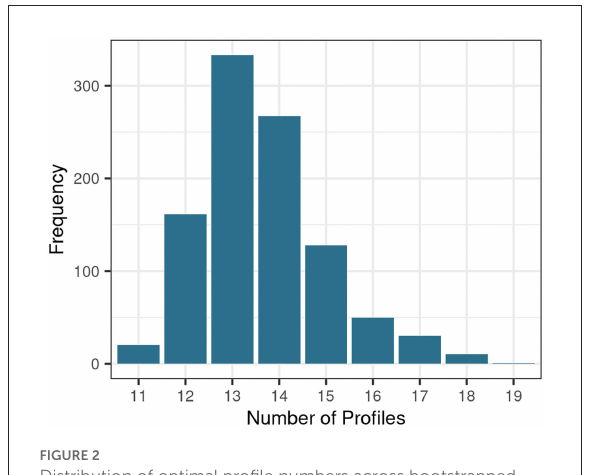
FIGURE2 Distribution of optimal profile numbers across bootstrapped